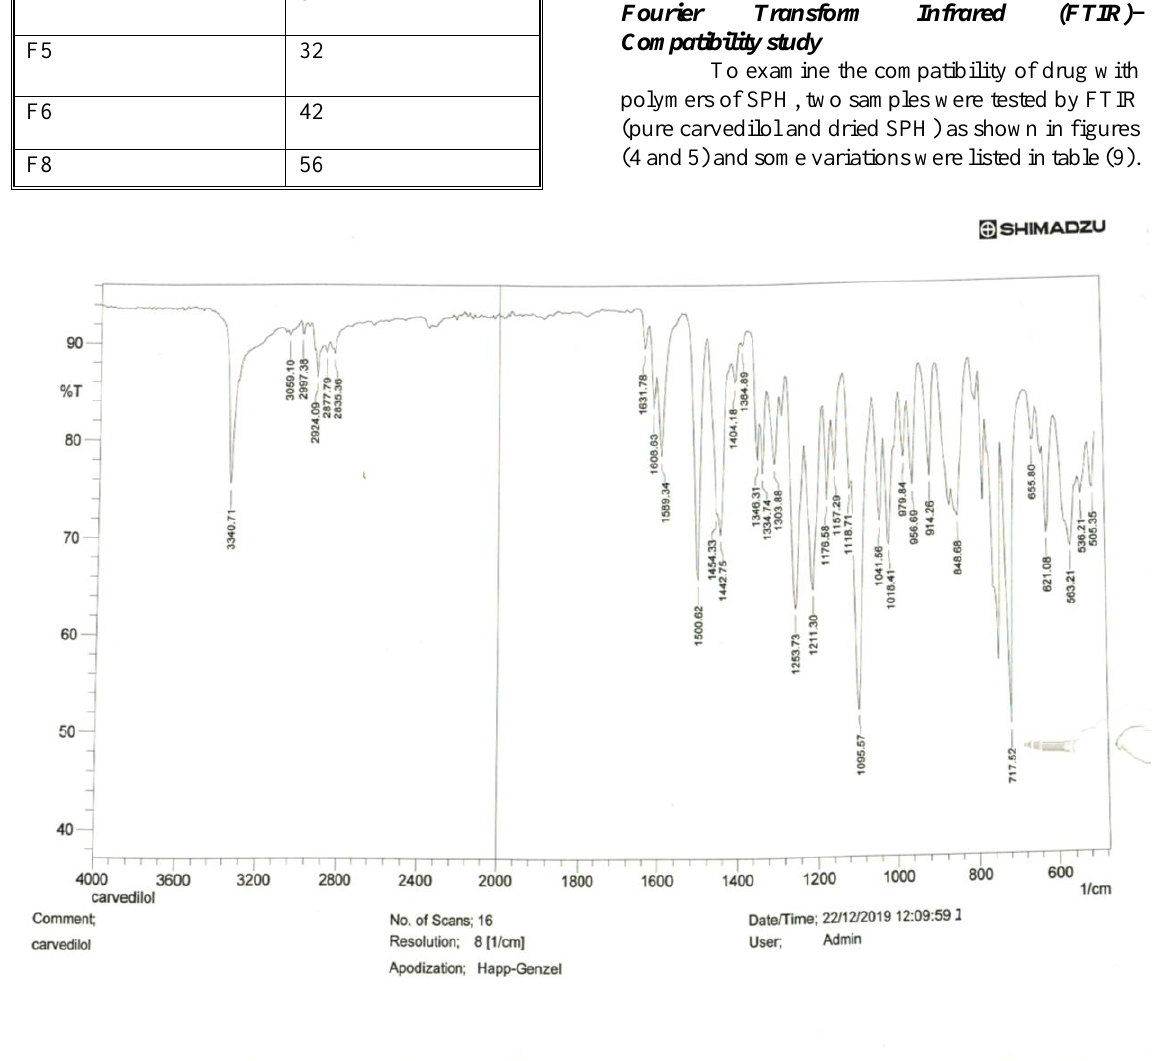
Table 8. Similarity Factor Values for Selection of Best Formula Formula